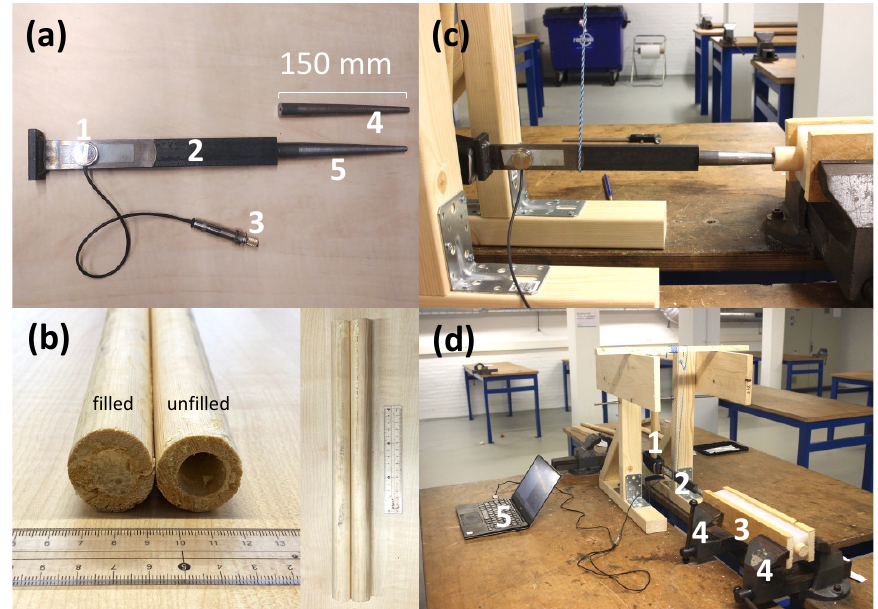
Figure 1. ( a ) The simplified implant model consisting of a contact microphone 1 , broach handle 2 , a 6.3 mm jack to the computer 3 , smaller broach 4 and a larger broach 5 . ( b ) Example of filled and unfilled bone model. Experiment setup ( c ) side view and overview ( d ) showing the swing hammer 1 , hammer and broach model with the attached microphone 2 , bone in silicone frame 3 clamped between two vices 4 and the computer to record and process the data 5 .